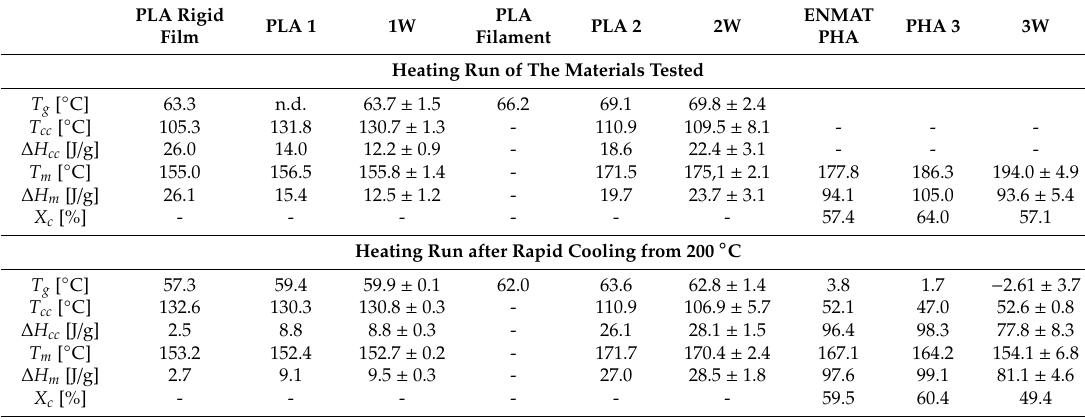
Table 2. Selected thermal properties of tested samples. Heating rate 20 ◦ C /